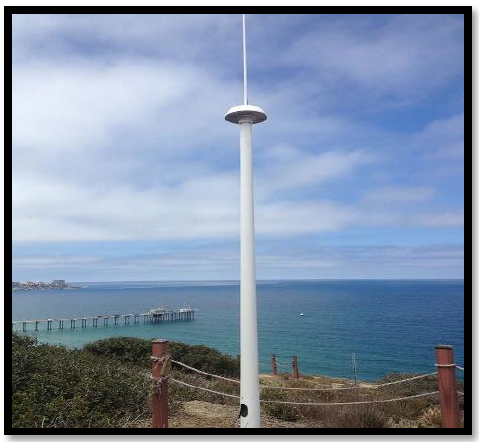
Figure 2. An example of high-frequency radars (Noaa,